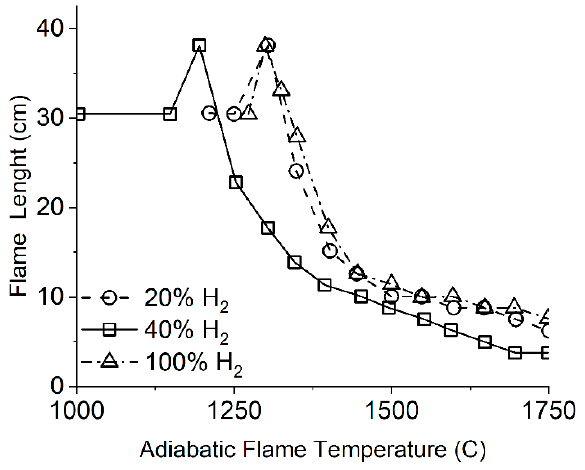
Figure 13. The relationship between the flame length and the temperature of adiabatic combustion at different volume contents of hydrogen [30].